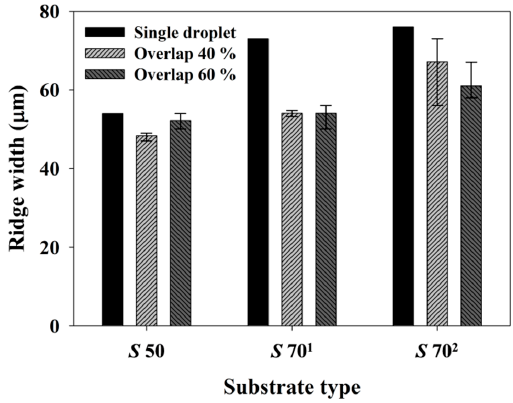
Figure 7. Variation of ridge width according to substrate types and droplet overlaps at room temperature.